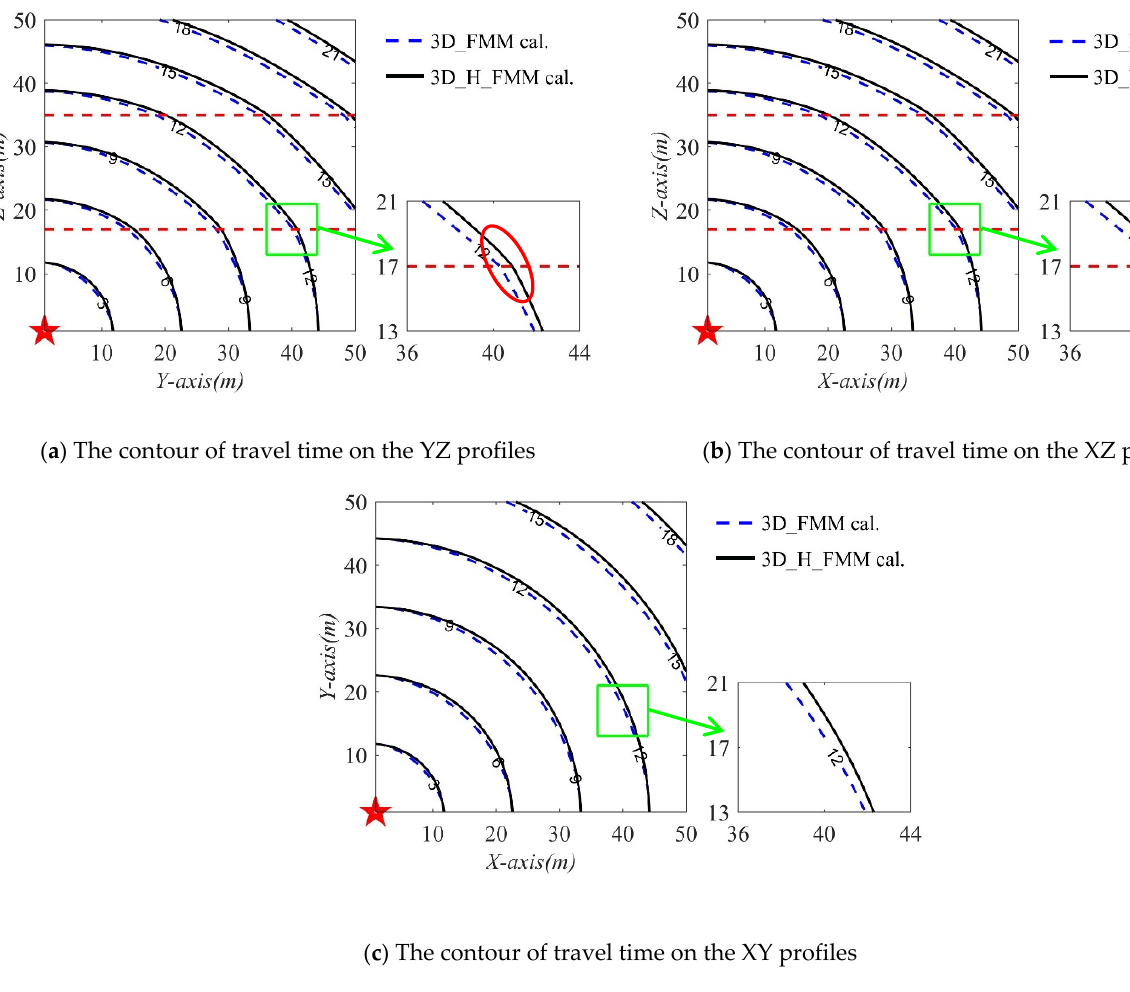
Figure 10. The contour of travel times of the three profiles of microseismic source point in the Case C: small-scaled inhomogeneous velocity model.